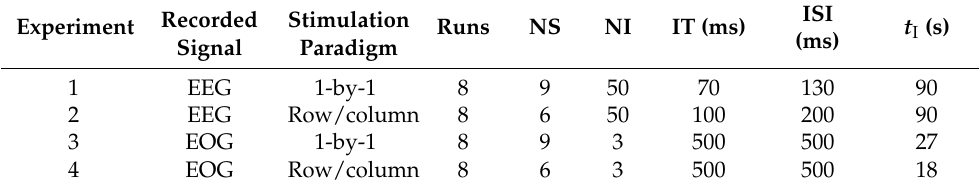
Table 2. Parameters selected for each experiment performed during recording sessions. NS: Number of Stimuli; NI: Number of Intensifications; IT: Intensification Time; ISI: Inter-Stimuli Interval; t I : time of the intensification